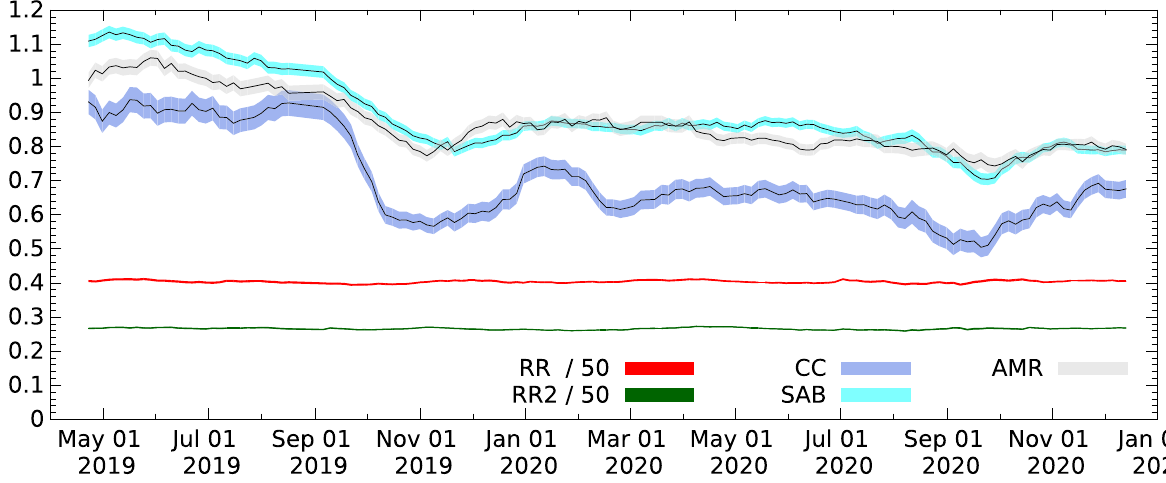
Figure 4. The averaged muon fluxes are shown with 1 standard deviation for the two Reference Regions (red- coloured and dark-green-coloured bands), Central Craters (blue-coloured band), Showa Crater and Arimura Basin (cyan-coloured band) and Arimura Middle Reaches (gray-coloured band), respectively.